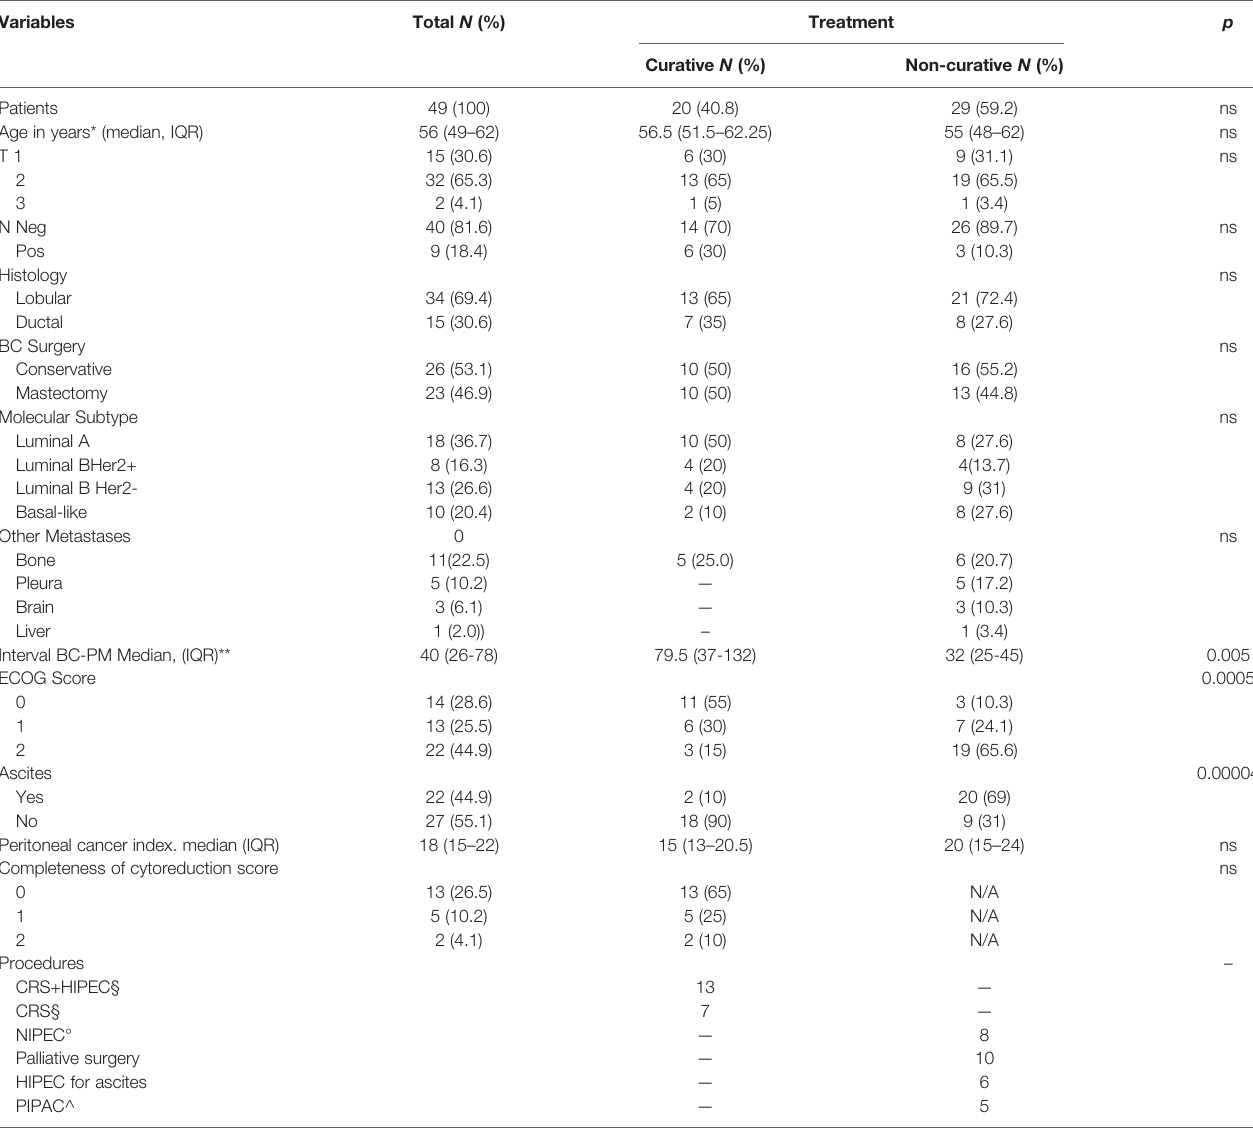
TABLE 1 | Clinical characteristics in the 49 patients with peritoneal metastases from breast cancer.